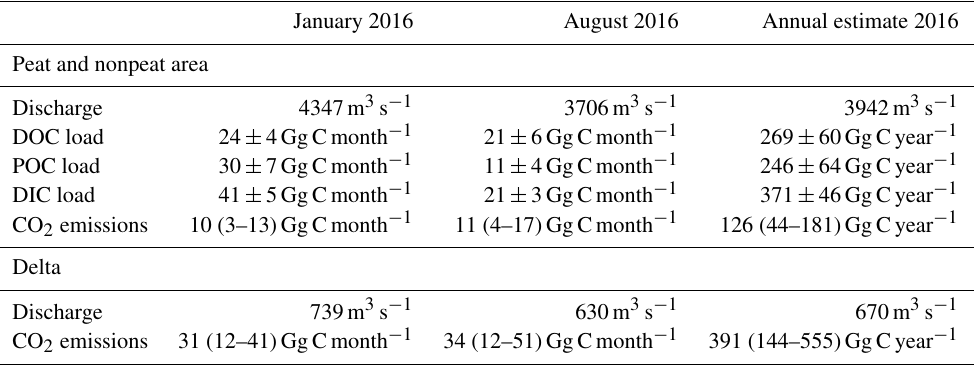
Table 3. Average discharge and calculated carbon loads and emissions to the atmosphere, estimated for the months of the two surveys and the whole year